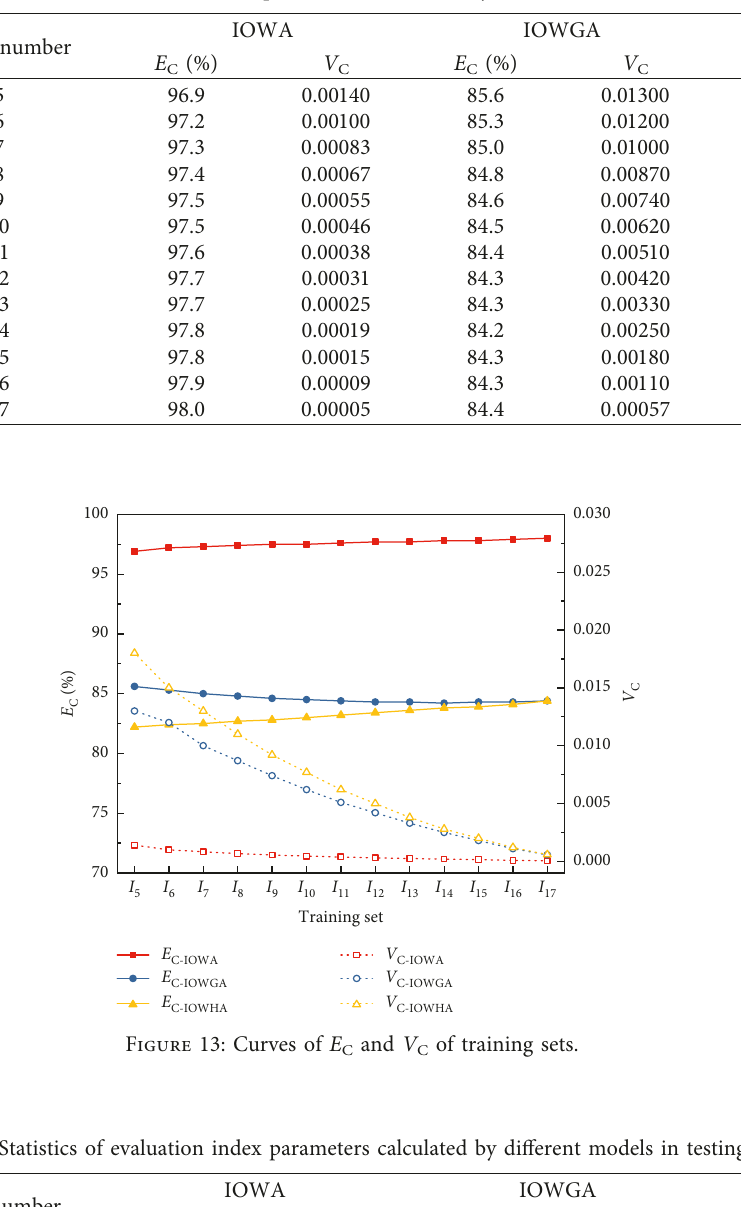
Table 7: Statistics of evaluation index parameters calculated by different models in training sets.